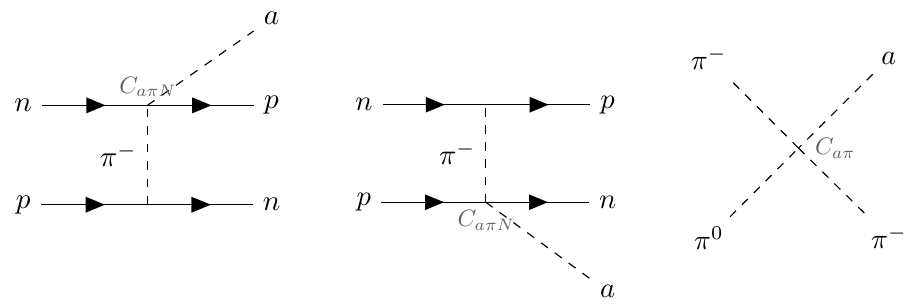
Figure 4 . Other diagrams involving the contact